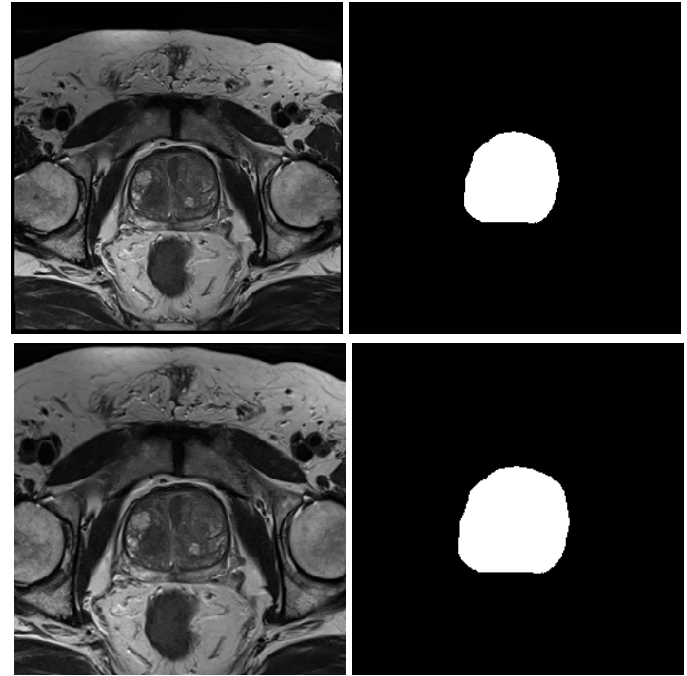
Figure 2. Center-cropping of MRI prostate image, original MRI ( top-left ), center-cropped image ( bottom-left ), and the corresponding masks ( top/bottom-right